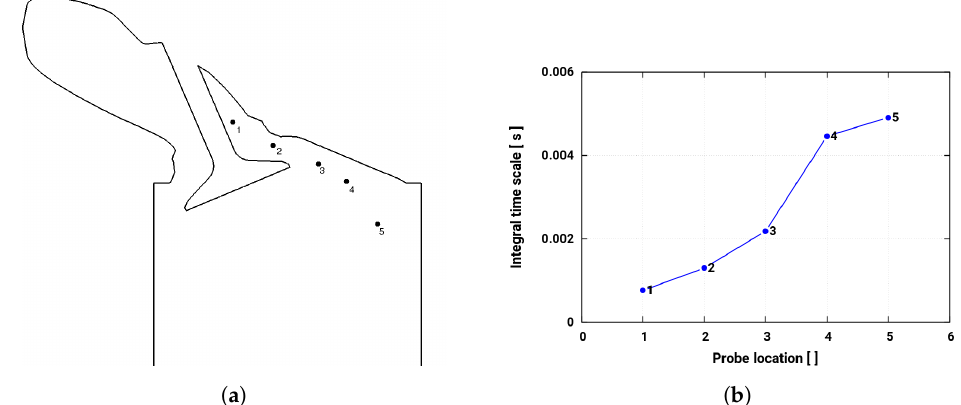
Figure 16. Evolution of integral time scale along charge intake stream: ( a ) probe locations, ( b ) integral time